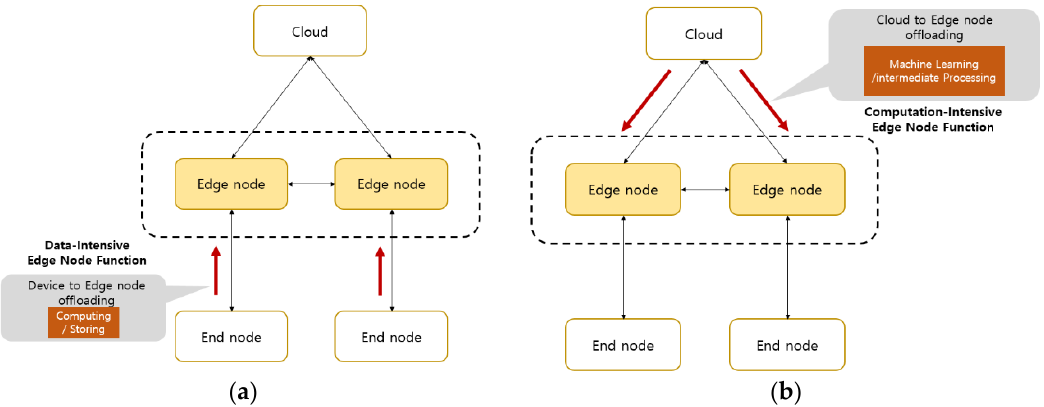
Figure 3. ( a ) Data ‐ intensive edge node function ( b ) Computation ‐ intensive edge node function.